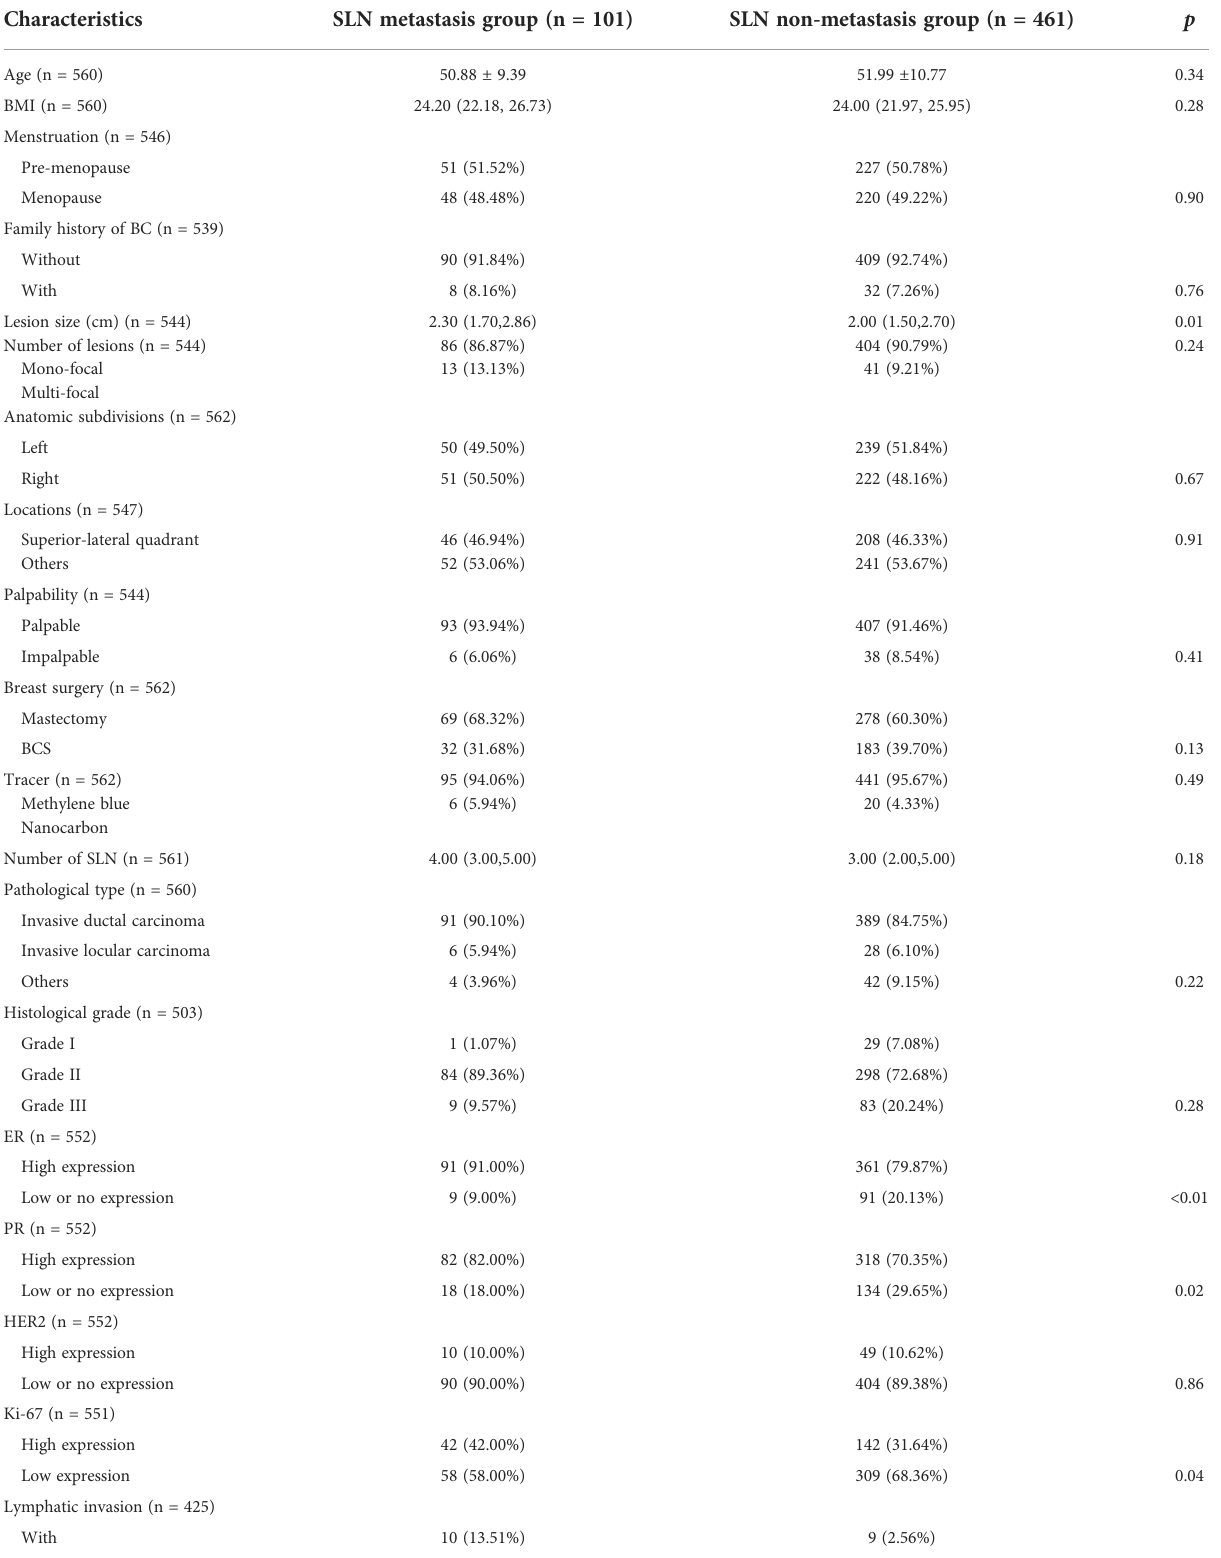
TABLE 1 Characteristics between SLN metastasis and SLN non-metastasis